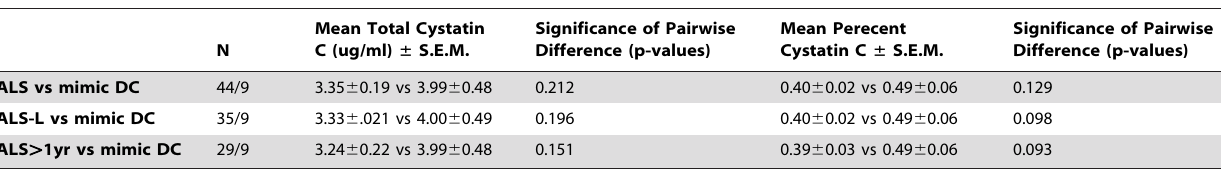
Table 3. CSF subgroup results for total and percent cystatin C.